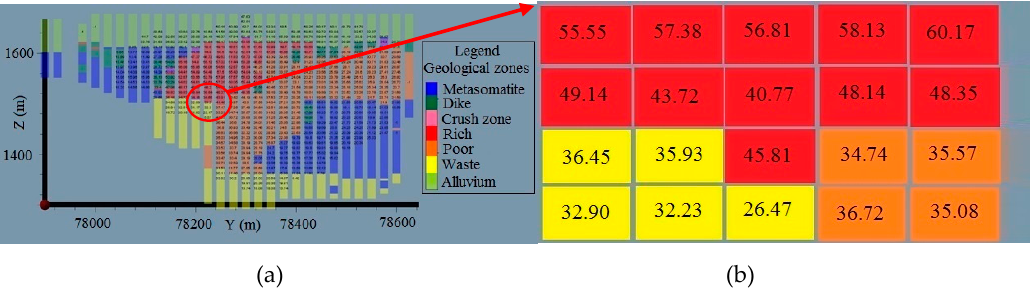
Figure 7. Example of an estimated geologic vertical section using local models ( a ), and zoom of one specific area ( b ).